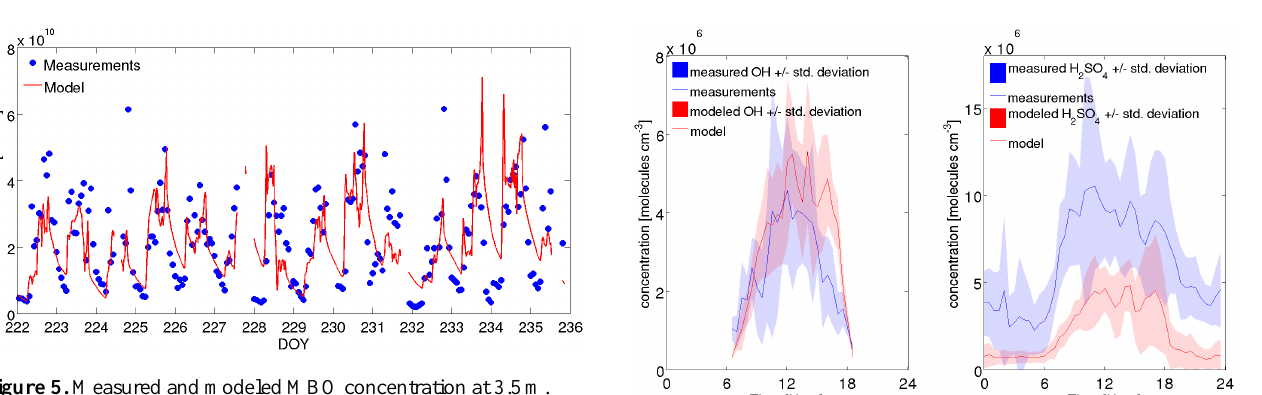
Figure 5. Measured and modeled MBO concentration at 3.5m.